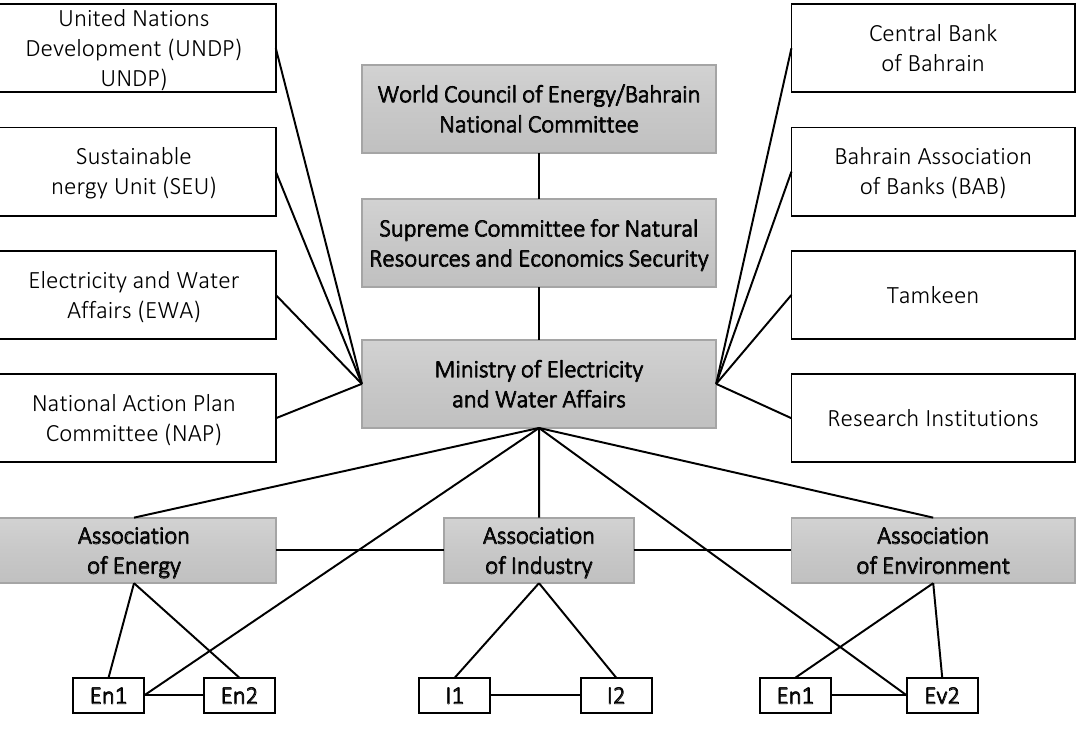
Figure 1. A pragmatic model for sustainable energy policy: Networking between the government of Bahrain and key